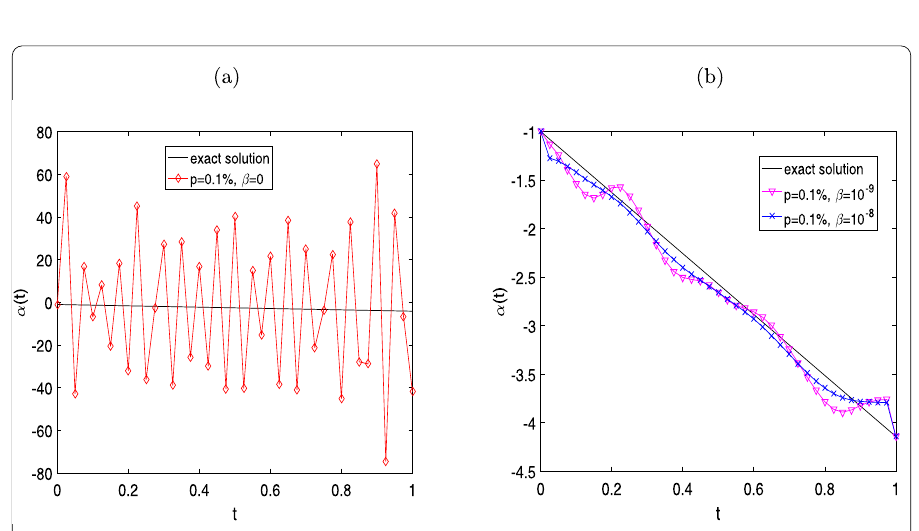
Figure 5 The analytical (36) and approximate α ( t ) with p = 0.1% for: ( a ) β = 0 and ( b ) β = 10 –9 and 10 –8